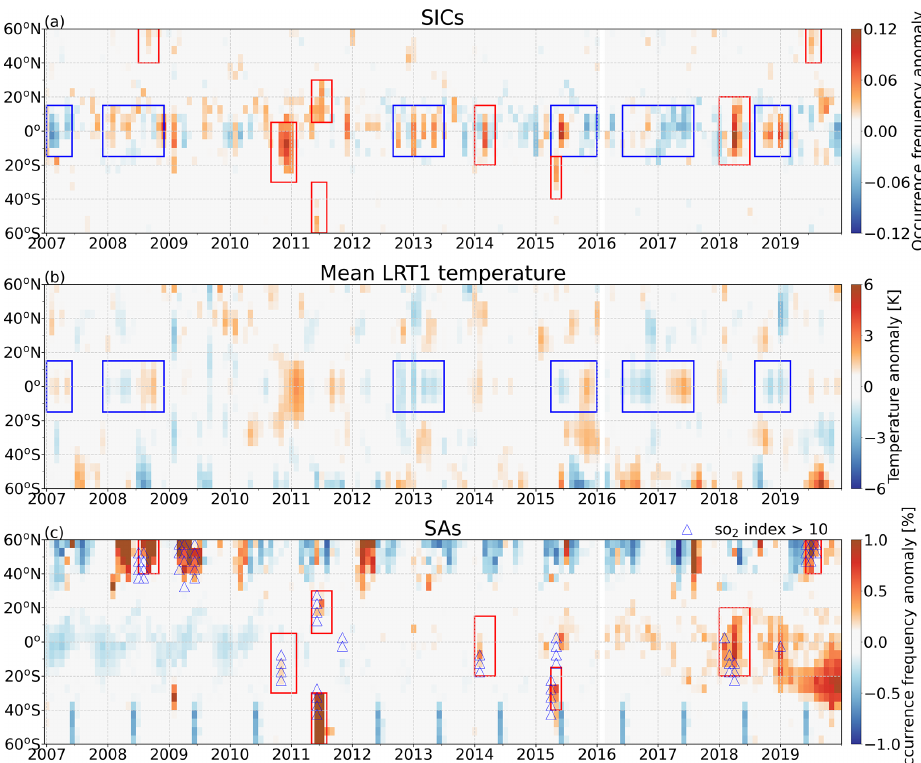
Figure 11. Monthly anomalies of SIC occurrence frequency, LRT1 temperature, and stratospheric aerosol occurrence frequency from 2007 to 2019. Blue triangles indicate a high SIC occurrence frequency related to strong volcanic events, as identified by an SI > 10K derived from AIRS observations. SIC anomalies that are negatively correlated with LRT1 temperatures are marked with blue boxes (shown in panels a and b ), and those positively correlated with SAs are marked with red boxes ( a and c